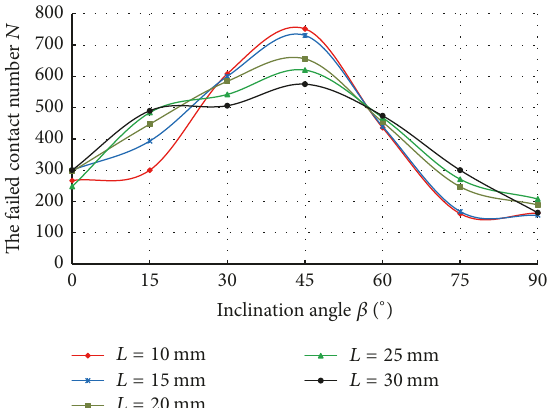
Figure 6: The failed contact numbers at the points of peak